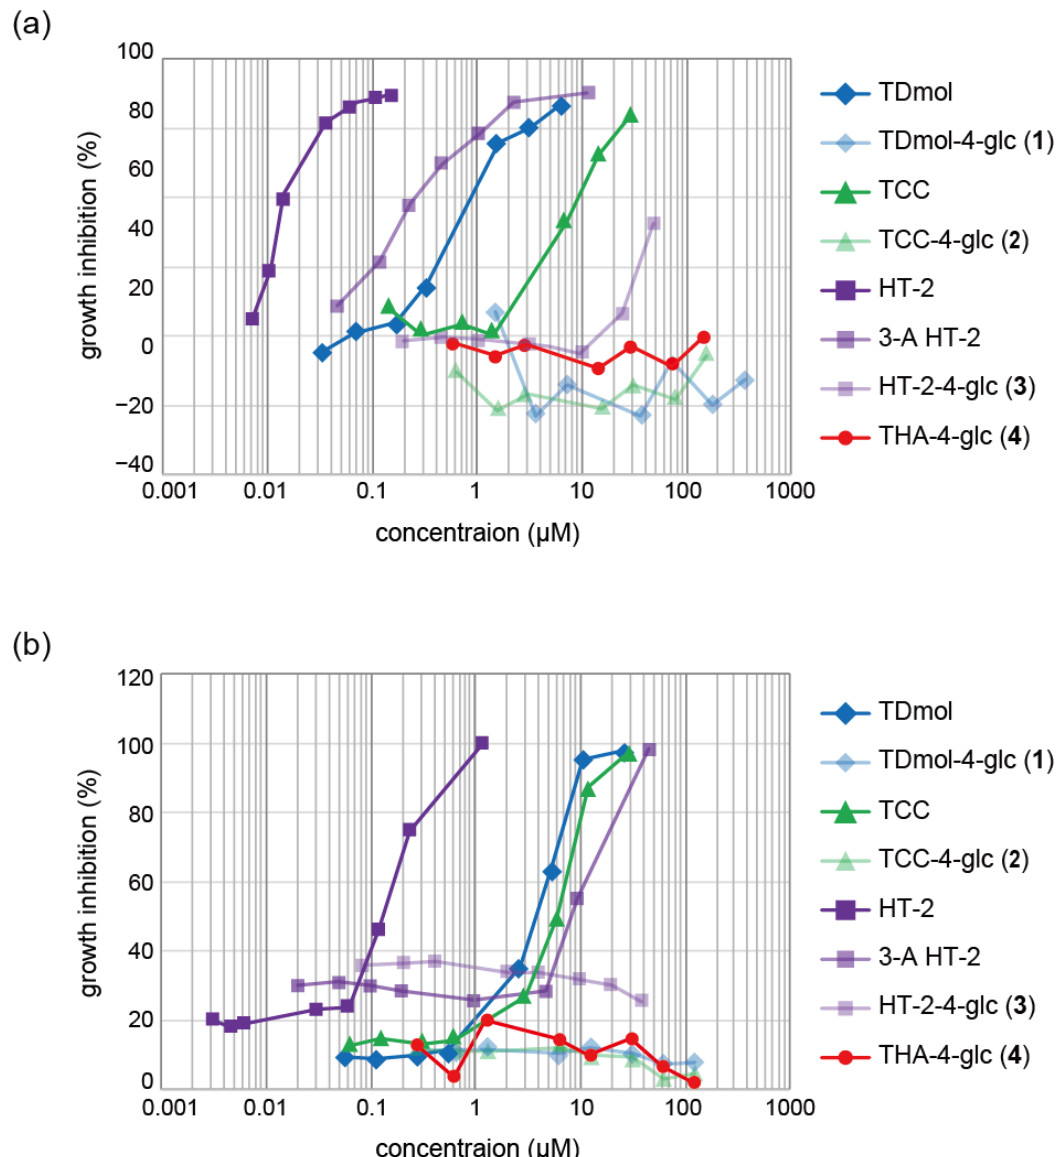
Figure 9. Dose-response cytotoxicity curves of trichothecenes. ( a ) Cytotoxicity assay using HL-60 cells. ( b ) Cytotoxicity assay using trichothecene hypersensitive yeast, pdr5 Δ erg6 Δ rpb4 Δ of Saccharomyces cerevisiae BY4742 mutant. The assays of HL-60 and yeast cells were carried out in 96-well plates.